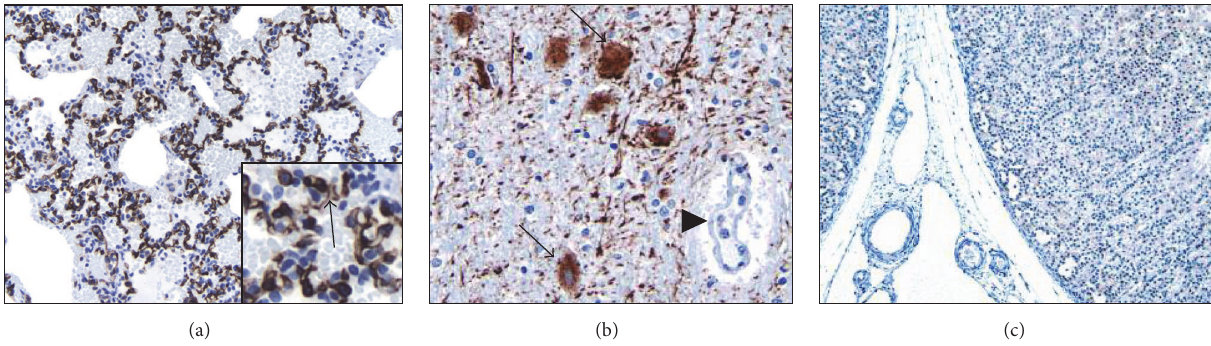
Figure 1: SERT expression is specific and sensitive to the lung microvasculature (3,3 󸀠 -diaminobenzidine, SERT antibody expression in brown). Autopsy tissue microarrays from newborns to 10 years of age showed crisp and diffuse SERT expression (arrow) in lung endothelium ((a) 200x;insetishighmagnification600x),withpositivecontrols((b)200x)highlightingnumerousserotoninergicneurons(arrows)intheRaphe nucleus (note negative endothelial staining of the adjacent small artery on the right, arrow head); all other organs had negative endothelial cell SERT staining as seen here in the adrenal ((c) 20x, no brown stain